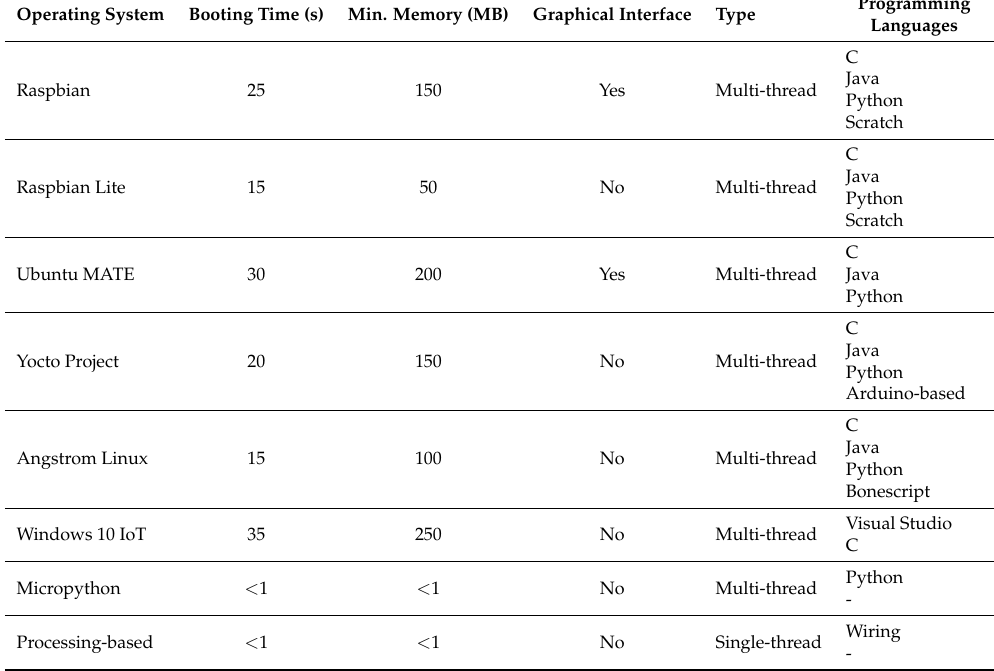
Table 4. Comparison of different operating